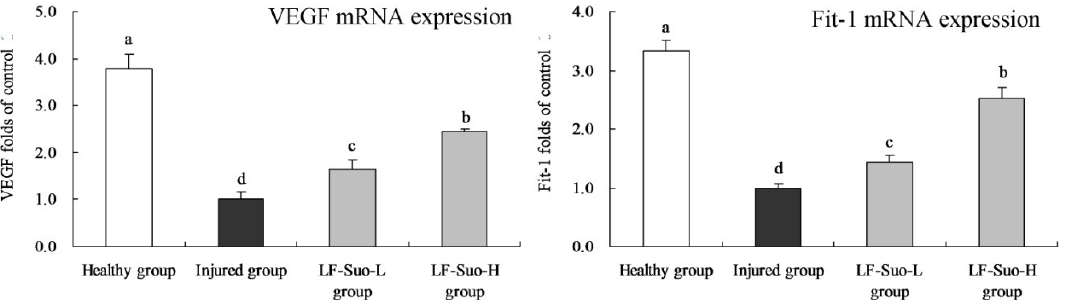
Figure 4. VEGF, Fit ‐ 1 mRNA expression of studied mice. Fold ‐ ratio: gene expression/GAPDH × injured group numerical value (injured group fold ratio: 1). a–d Mean values with different letters in the same column are significantly different ( p < 0.05) according to Duncan’s multiple ‐ range test. LF ‐ Suo ‐ L, Lactobacillus fermentum Suo (0.5 × 10 9 CFU/kg b.w.); LF ‐ Suo ‐ H, Lactobacillus fermentum Suo (1.0 × 10 9 CFU/kg b.w.).